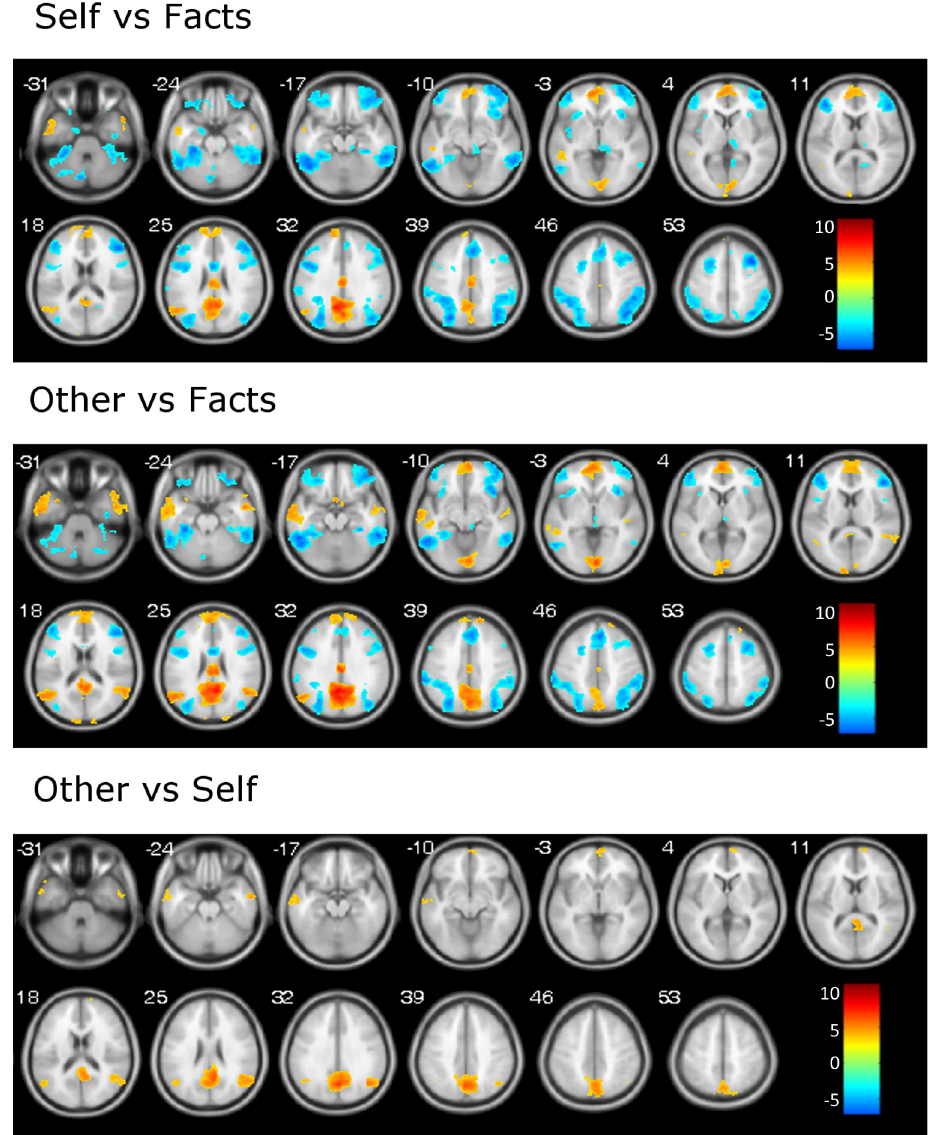
Fig 2. Activation map for the self-reflection task. Warm colors represent self > facts (upper row), other > facts (middle row) and other > self (lower row) contrasts, cold colors represent facts > self (upper row) and facts > other (middle row) contrasts. Numbers indicate z coordinate in MNI space. Images are displayed in neurological convention (right is right). Color bar depicts Z values.